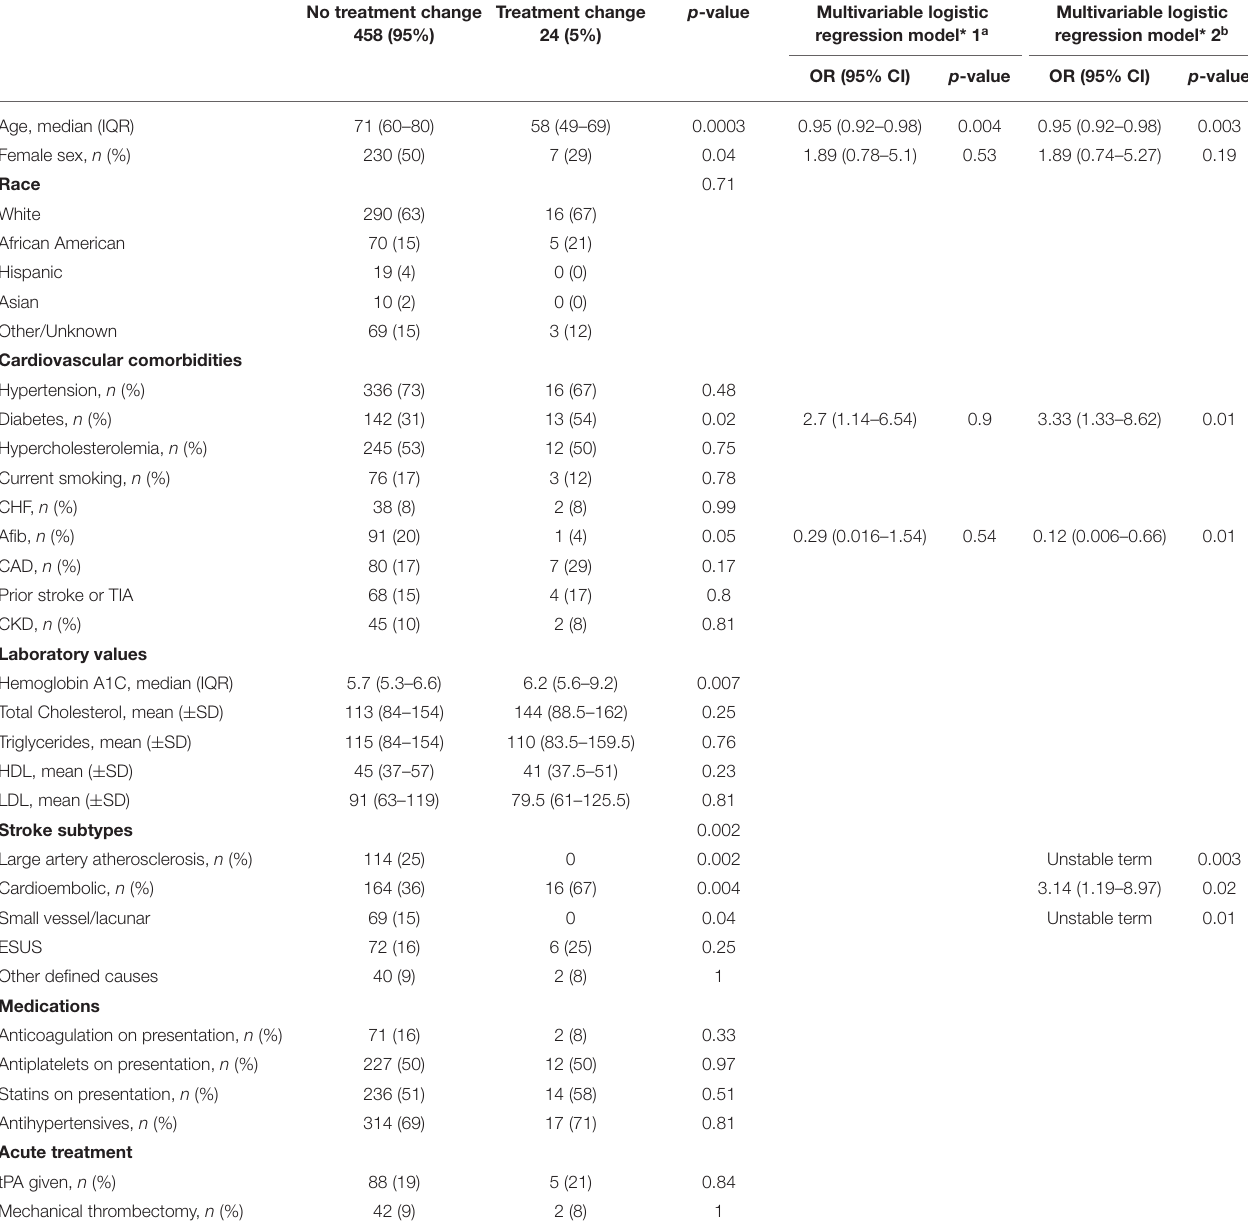
TABLE 4 | Comparisons between patients according to TTE role in treatment